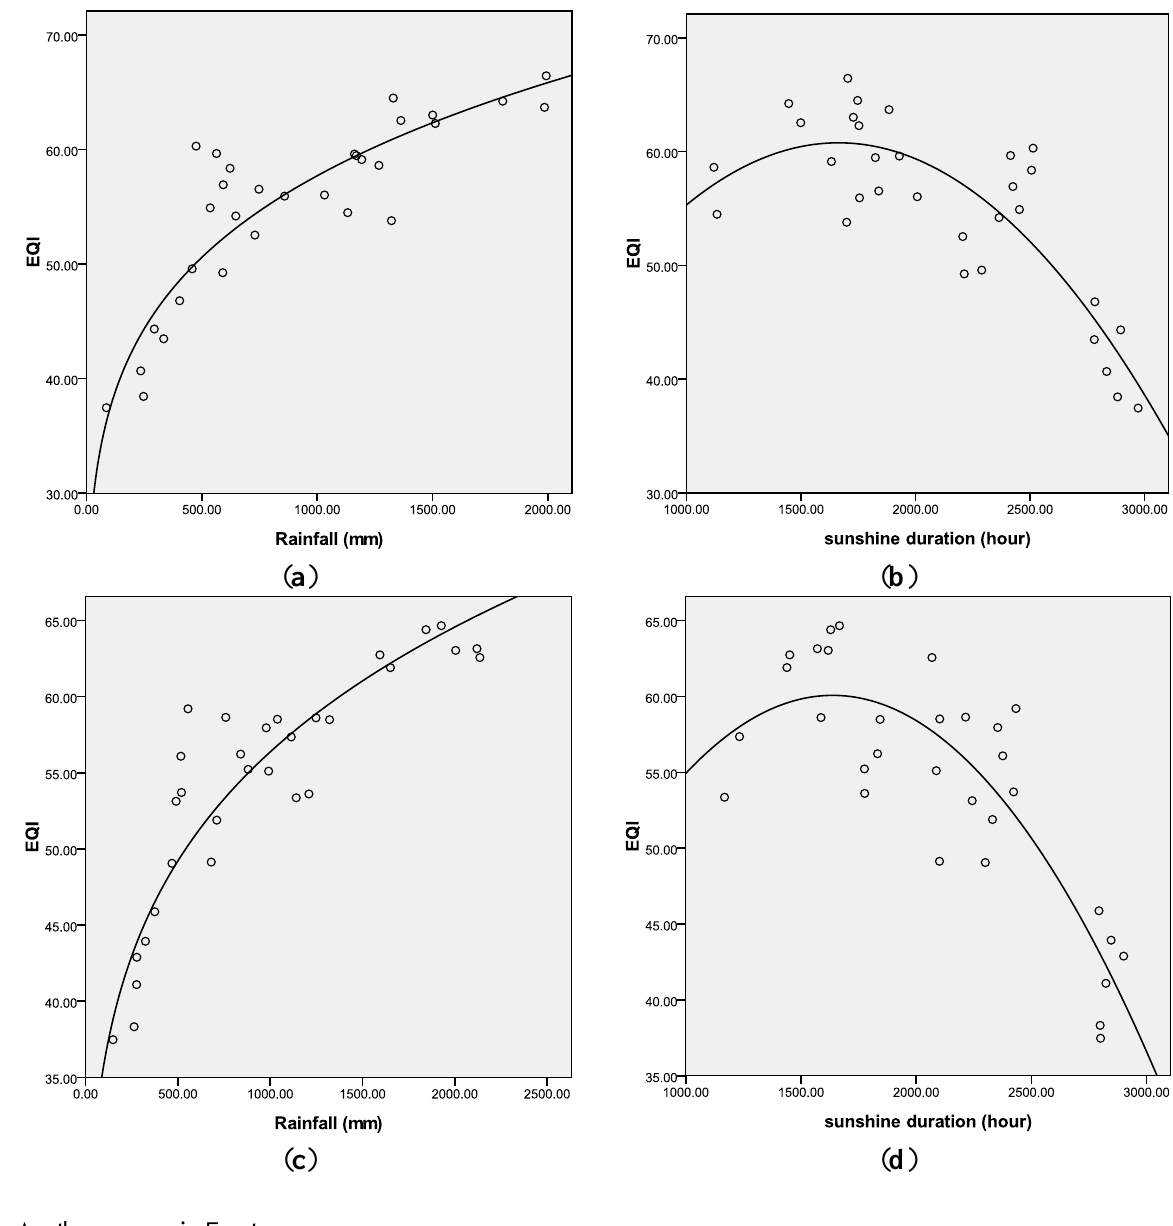
Figure 10. Best-fit curves for EQI, rainfall and sunshine duration in 2008 and 2010. ( a ) EQI and rainfall in 2008; ( b ) EQI and sunshine duration in 2008; ( c ) EQI and rainfall in 2010; ( d ) EQI and sunshine duration in